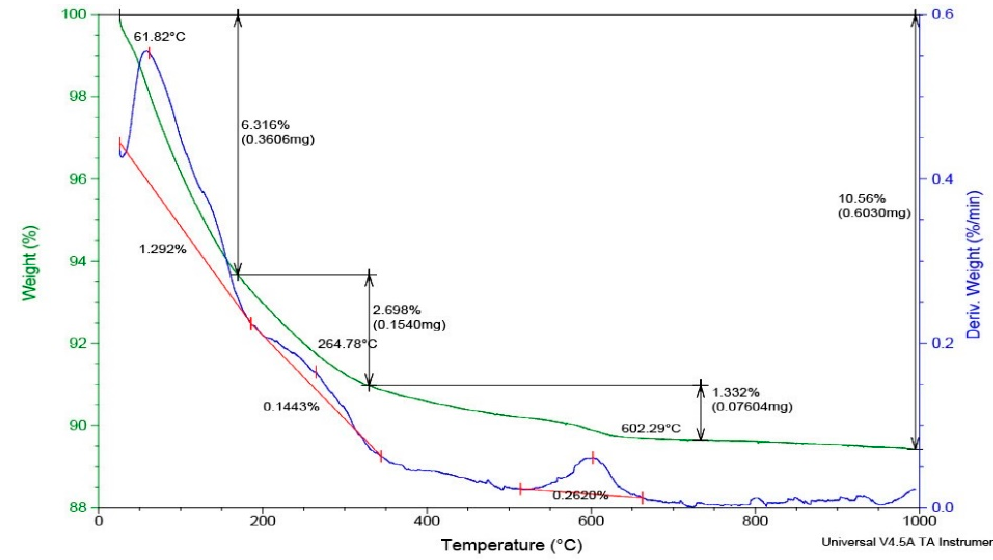
Figure 4. Thermogravimetric analysis (DSC-TGA) of the zeolitic tuff sample. 2.2. Experiments for NH 3 Adsorption of from the Air 2.2.1. Adsorption of NH 3 Released from 0.5 mL NH 4 OH 25%